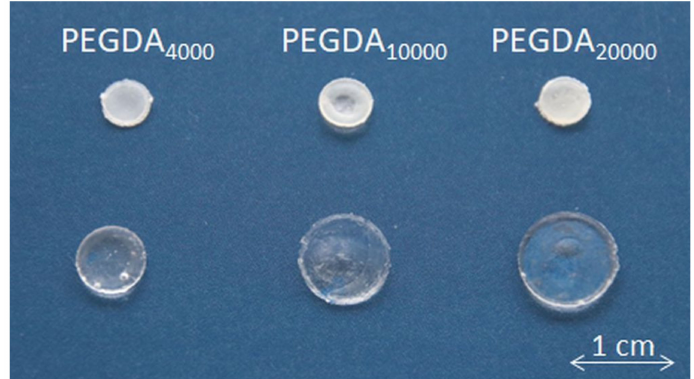
Figure 6. Macrophoto of exemplary samples PEGDA 4000 , PEGDA 10000, and PEGDA 20000 with 40 wt % polymer content before ( top ) and after ( bottom ) 24 h of swelling in a TES buffer at 37 ◦